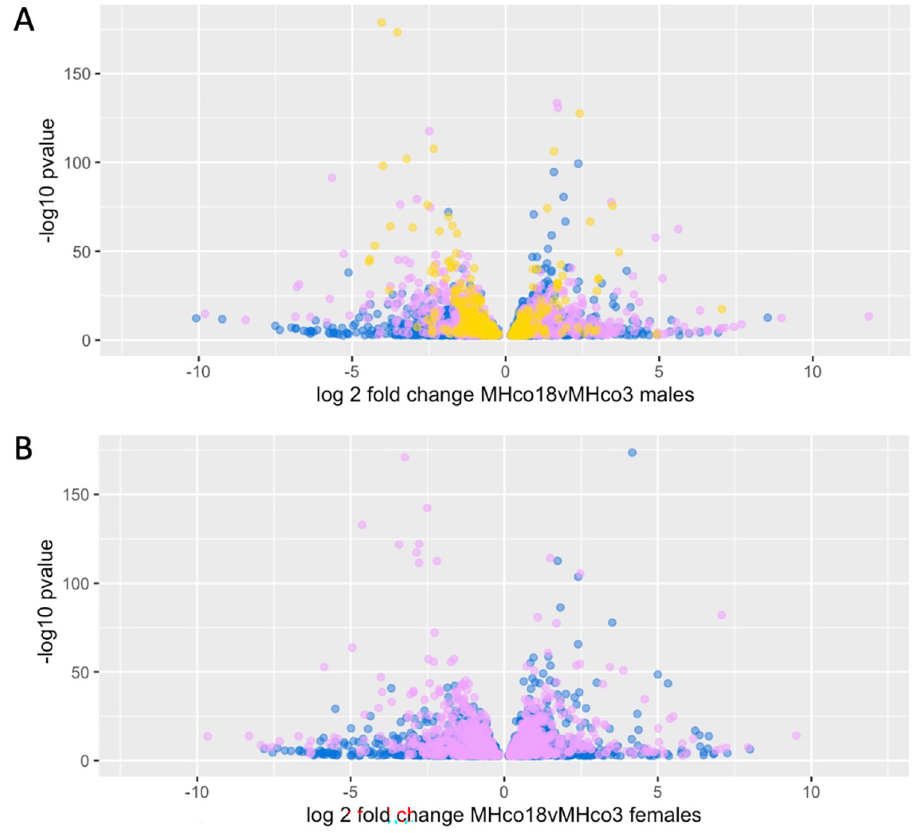
Fig 4. Volcano plots showing differentially expressed genes in male (A) and female (B) samples (adj P < 0.01). Blue points represent genes that are only differentially expressed in the parental (MHco18 vs MHco3) comparisons. If purple, they are also differentially expressed in the F2IVM vs MHco3 comparisons. If yellow (males only), they are also differentially expressed in the F2IVM vs F2CTL